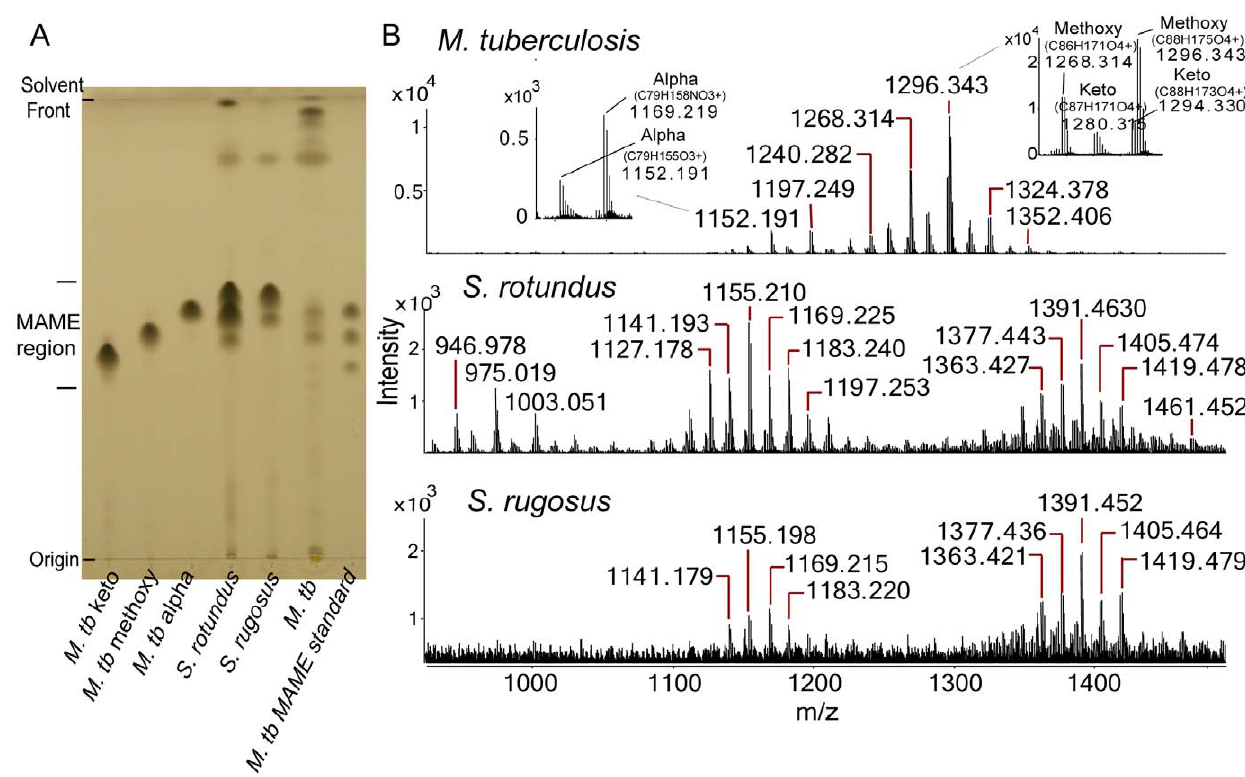
Figure 2. Purification and analysis of Segniliparus mycolates. (A) Normal phase one-dimensional thin-layer chromatography (1D TLC) of saponified and esterified lipids from M. tuberculosis (M. tb) , S. rugosus and S. rotundus . From left to right: Lanes 1, 2, 3, and 7 were loaded with purified keto (1), methoxy (2), alpha (3), or mixed (7) MAMEs of M. tuberculosi s. Lanes 4, 5, 6 were loaded with methylated saponificates containing both fatty acyl methyl esters and MAMEs derived from S. rotundus (4), S. rugosus (5), or M. tuberculosis ( M. tb , 6). (B) Positive-ion mode Q-Tof ESI-MS analysis of total MAMEs derived from M. tuberculosis (top panels), with insets showing mass values that deduce to chemical formulas having either 3 ( a ) or 4 (keto, methoxy) oxygen atoms and compared with MAMEs from S. rotundus and S. rugosus (middle and bottom